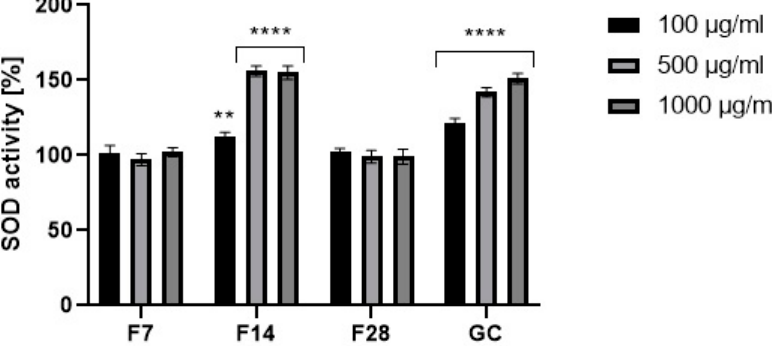
Figure 7. Effect of coffee beans’ extract and kombucha ferments on superoxide dismutase activity. Data are the mean ± SD of three independent experiments, in which each concentration was tested in duplicate. **** p < 0.0001, ** p < 0.002.